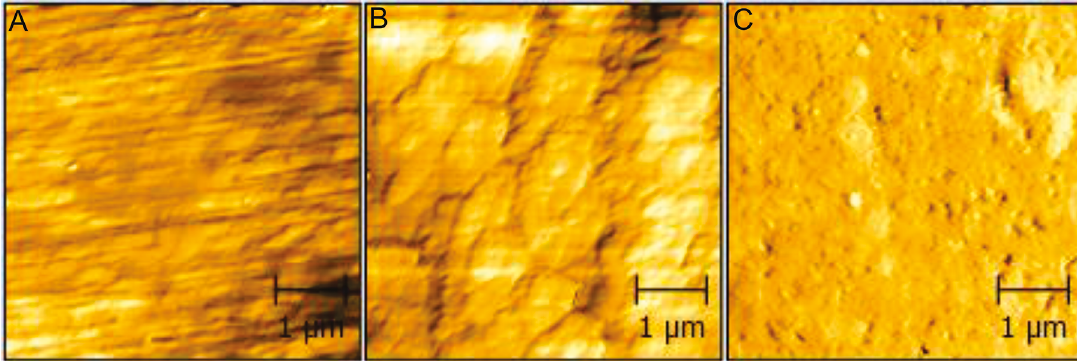
Figure 9. AFM images of C-steel surface topography at 25 °C: (A) before immersion; (B) after 2.0 hr of immersion in 1.0 mol∙L -1 HCl; (C) after 2.0 hr of immersion in inhibited acid solution (1.0 mol∙L -1 HCl +100 mg∙L -1 Aniba canelilla